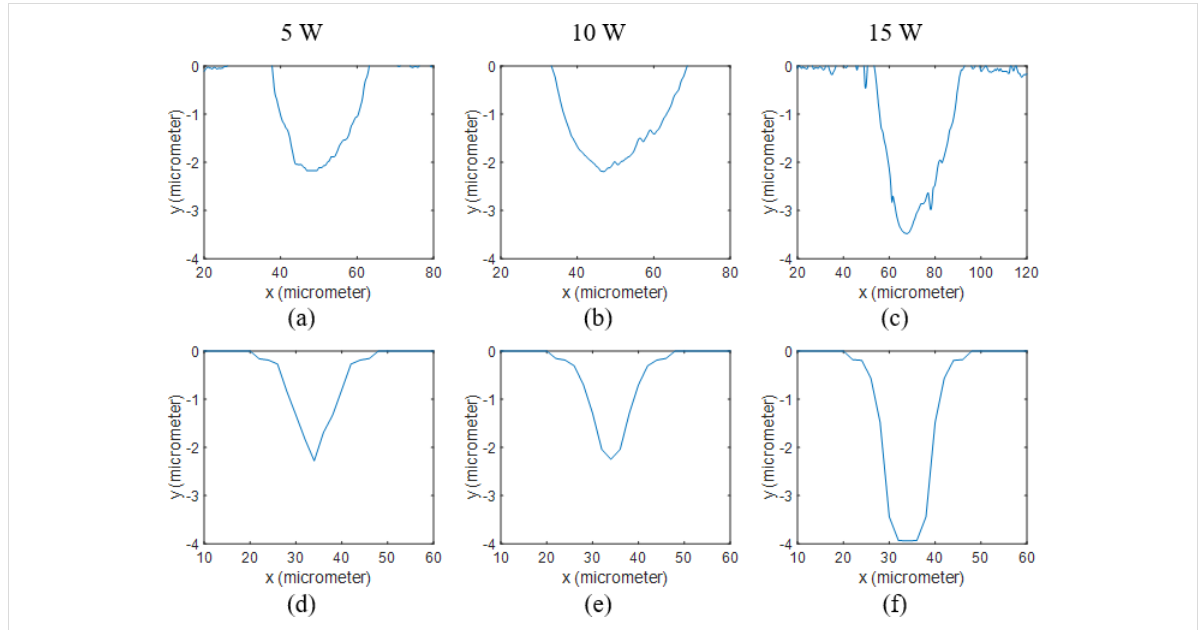
Figure 7: 2D profiles of Au coated Si samples processed at 50 kHz. Results obtained from measurements when using (a) 5 W, (b) 10 W and (c) 15 W are compared to the ones calculated through the numerical model at (d) 5 W, (e) 10 W and (f) 15 W.